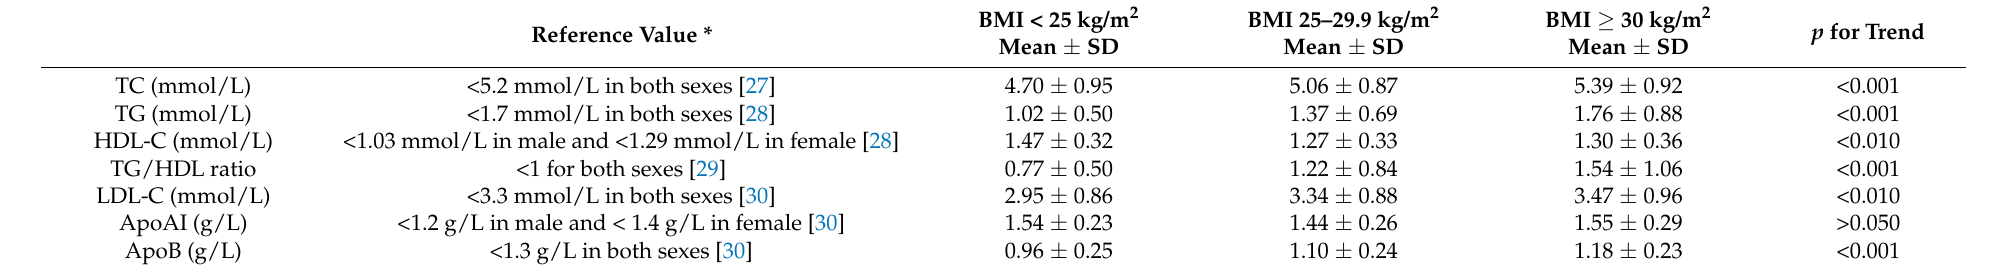
Table 2. Clinical characteristics of the study